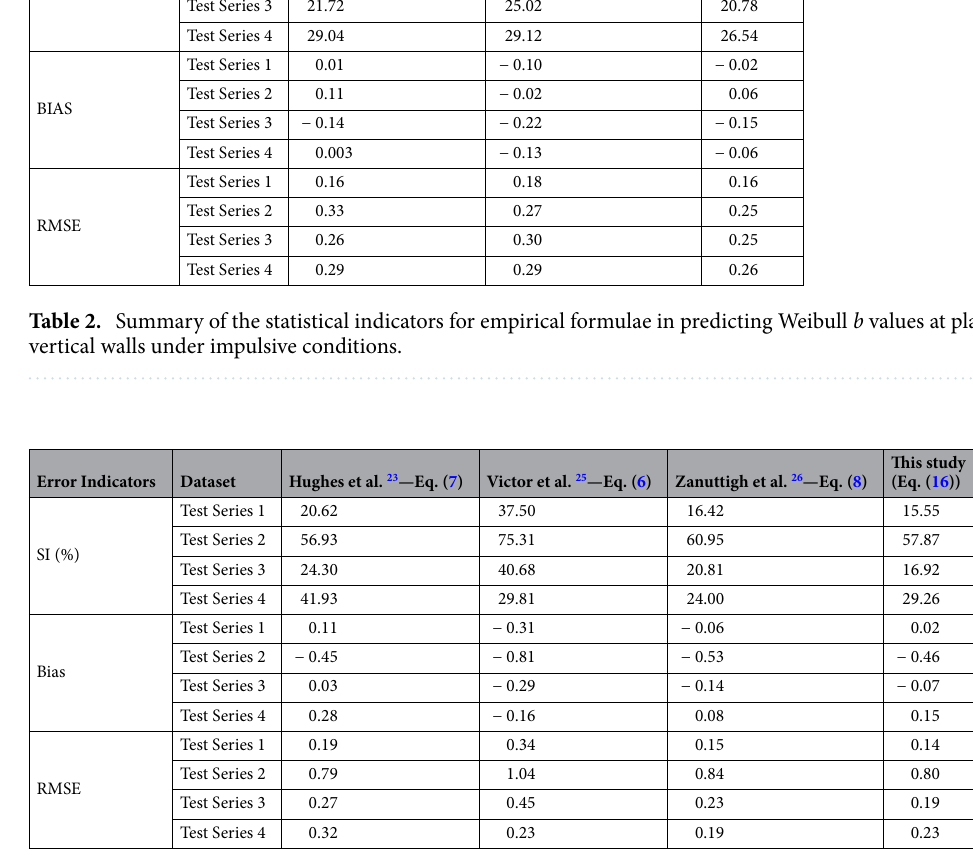
Table 3. Summary of the statistical indicators for empirical formulae in predicting Weibull b values at plain vertical walls under non-impulsive conditions.